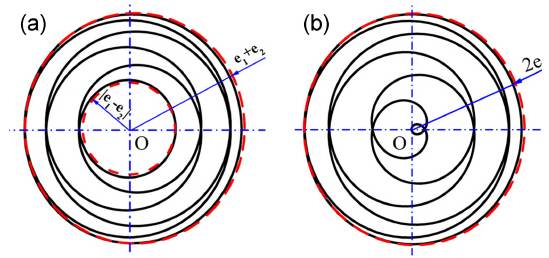
Figure 10. Motion curve of O 2 when ω 1 (cid:54)= ω 2 and ω 1 · ω 2 > 0 ( ω 1 /ω 2 = 6 / 7). (a) e 1 (cid:54)= e 2 , (b) e 1 = e 2 = e